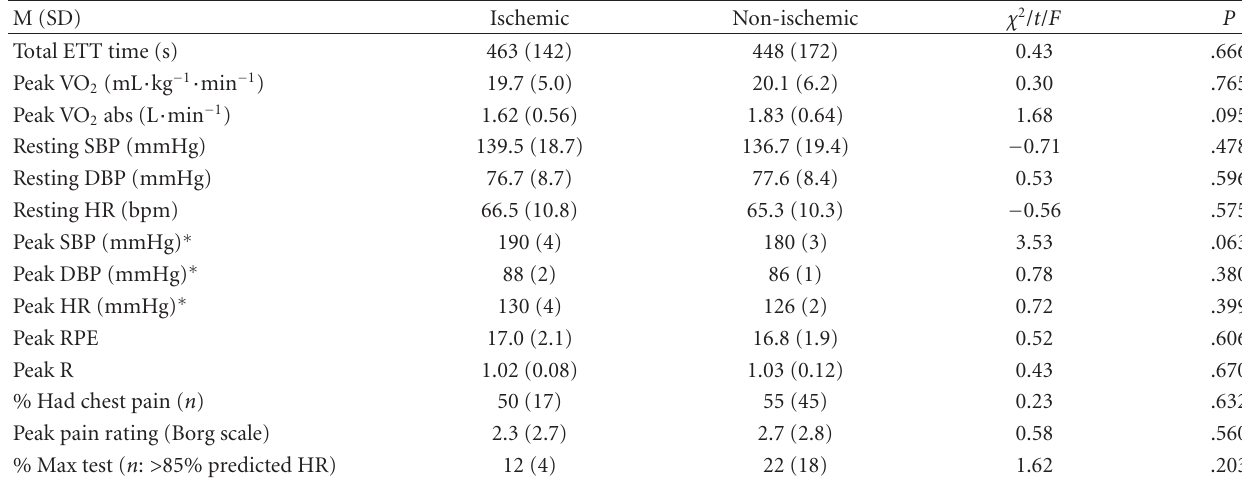
Table 2: Exercise variables for those patients with and without exercise-induced ischemia.